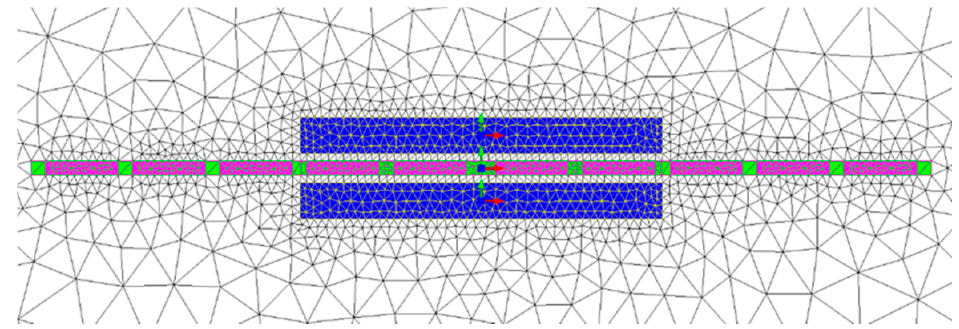
Figure 14. Physical model discretization network.